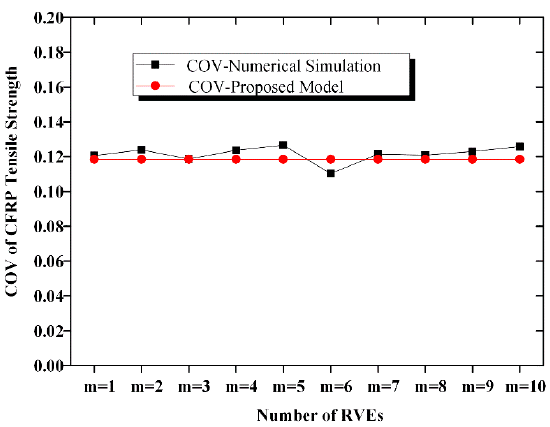
Figure 12. Comparison of the mean strength of the n-element series system.